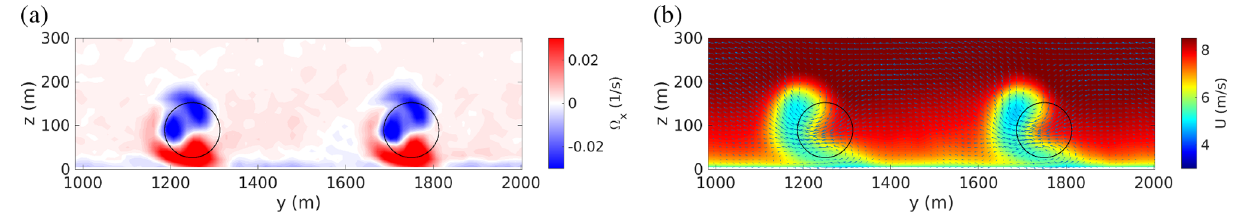
Figure 7. Yaw control: cross-stream view of the mean streamwise vorticity and velocity fields with upwind turbines yawed by γ = 30 ◦ and operated at β = − 4 ◦ . The signature of the two vertically staked counter-rotating streamwise vortices forced by the yawed rotor combined with wake rotation is clearly visible in the streamwise vorticity field (a) extracted 3 D downstream of the first turbine row. Their effect on the lateral displacement of the wake is clearly discernible in the streamwise (color scale) and cross-stream (arrows) velocity fields (b) extracted D/ 2 upstream of the second row of turbines. Only the fields of the two central turbine columns (between y = 1000 and 2000m) are shown.